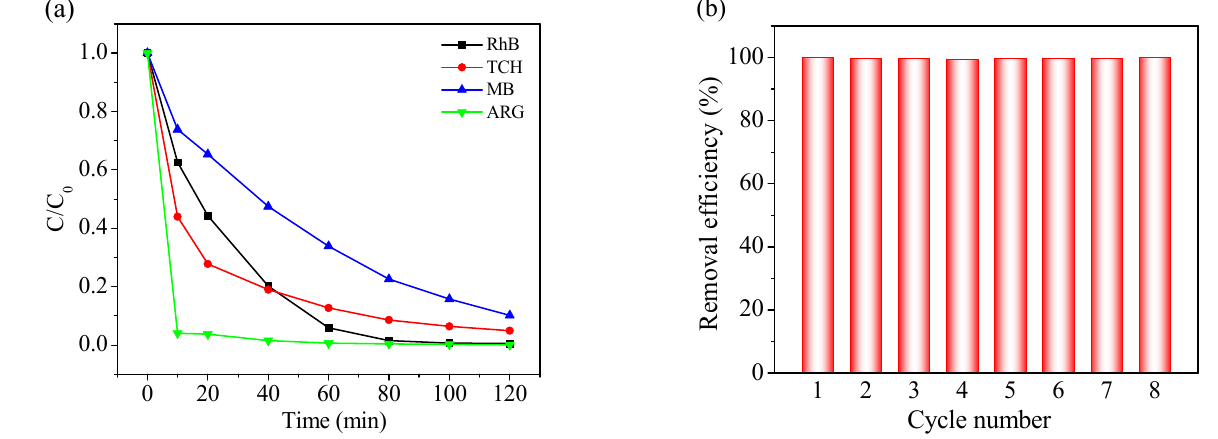
Figure 4. ( a ) Degradation of TCH, MB, and ARG in the CoAl 2 O 4 -500/PMS system, ( b ) cycling experiments of CoAl 2 O 4 -500 toward RhB degradation in the presence of PMS.